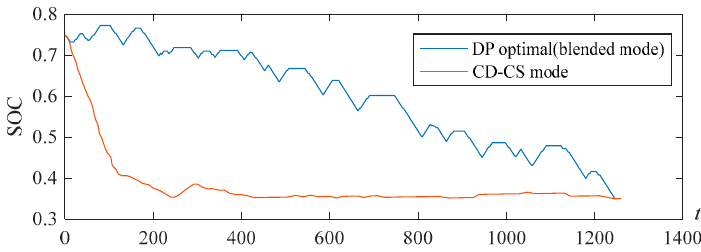
Figure 3. Depiction of the comparison between the CD–CS strategy and blended strategy.